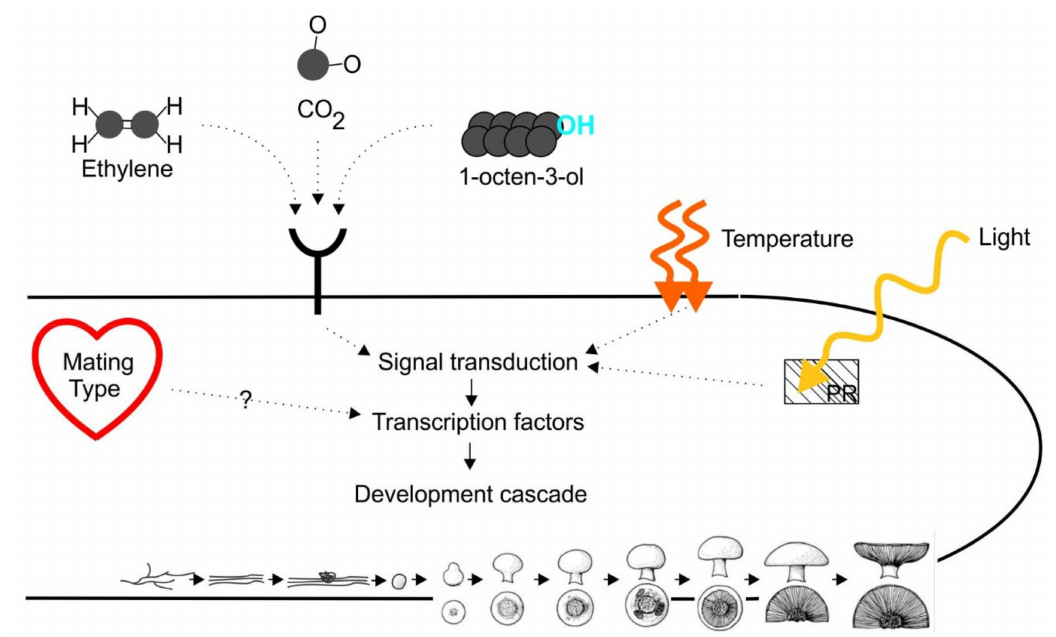
Figure 4. Overview of the main elements in the regulatory system involved in the initiation of the formation of primordia in basidiomycetes. PR = Photoreceptor. (adapted from Nagy et al. [4]). Initiation of fruiting body development in A. bisporus is influenced by carbon dioxide, temperature and the removal of a self-produced inhibitor (either ethylene or C 8 -compounds or perhaps both?). Light is not known to be involved in the fruiting process of A. bisporus . Details on how these factors link to mating type and transcription factors are presently not